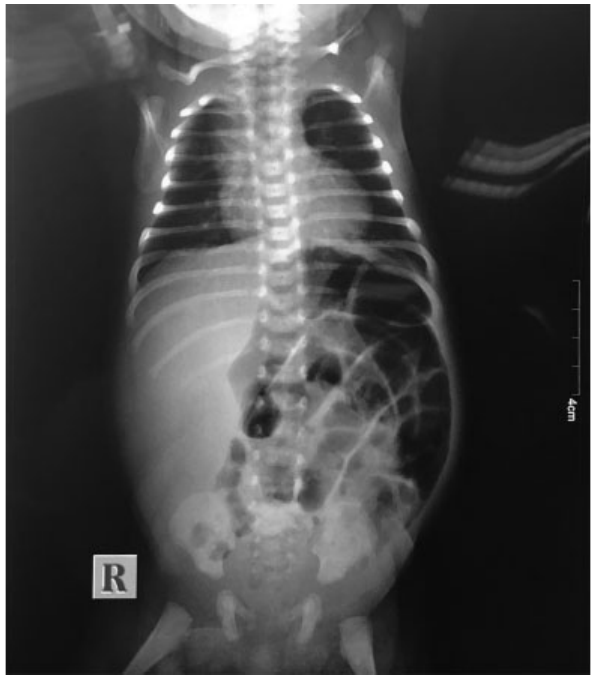
Fig. 2 Preoperative abdominal X-ray.